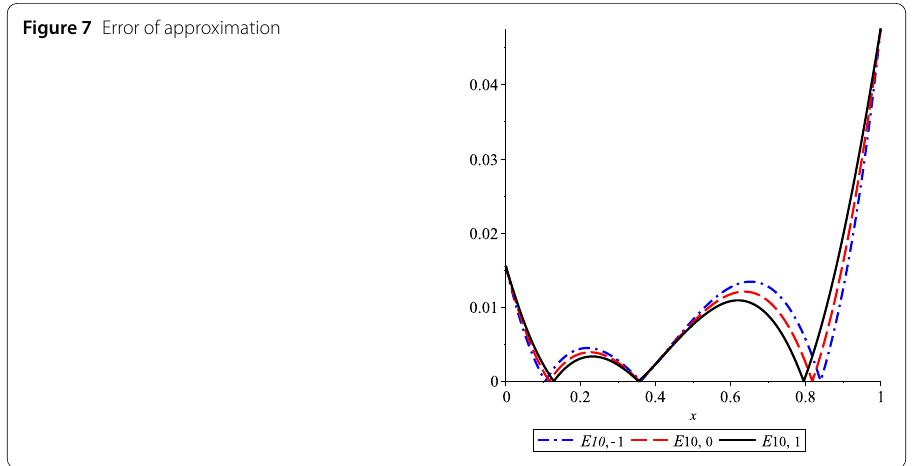
Figure 7 Error of